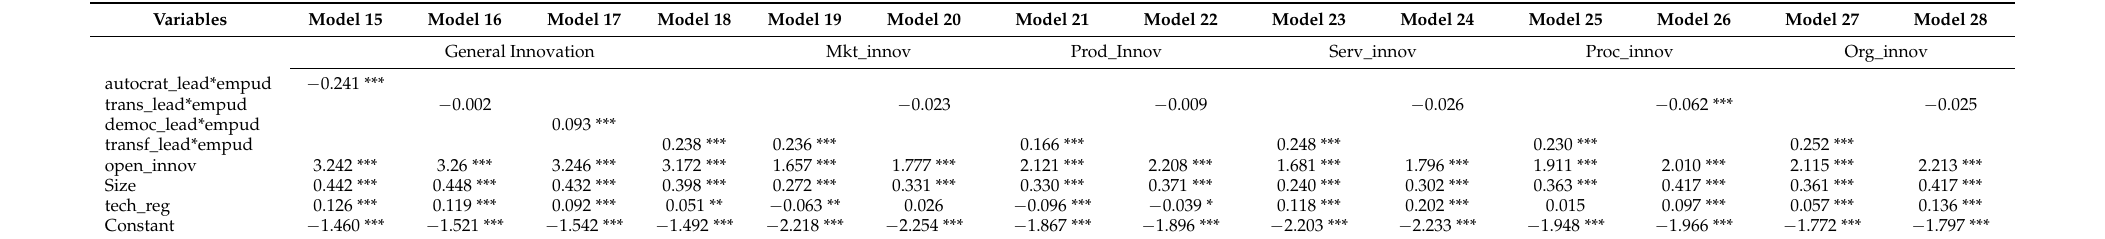
Table 6. Econometric Estimations of Moderation